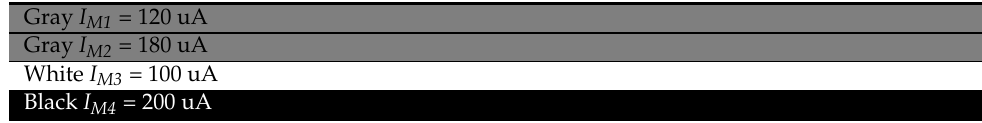
Figure 11. ( a – g ) The computed waveforms for five coupled oscillators; ( f , g ) the triangular character of change memristor resistances R (t) for the third and fourth oscillator. Table 3. The example of input pattern with two gray pixels with “small” frequency deviation.